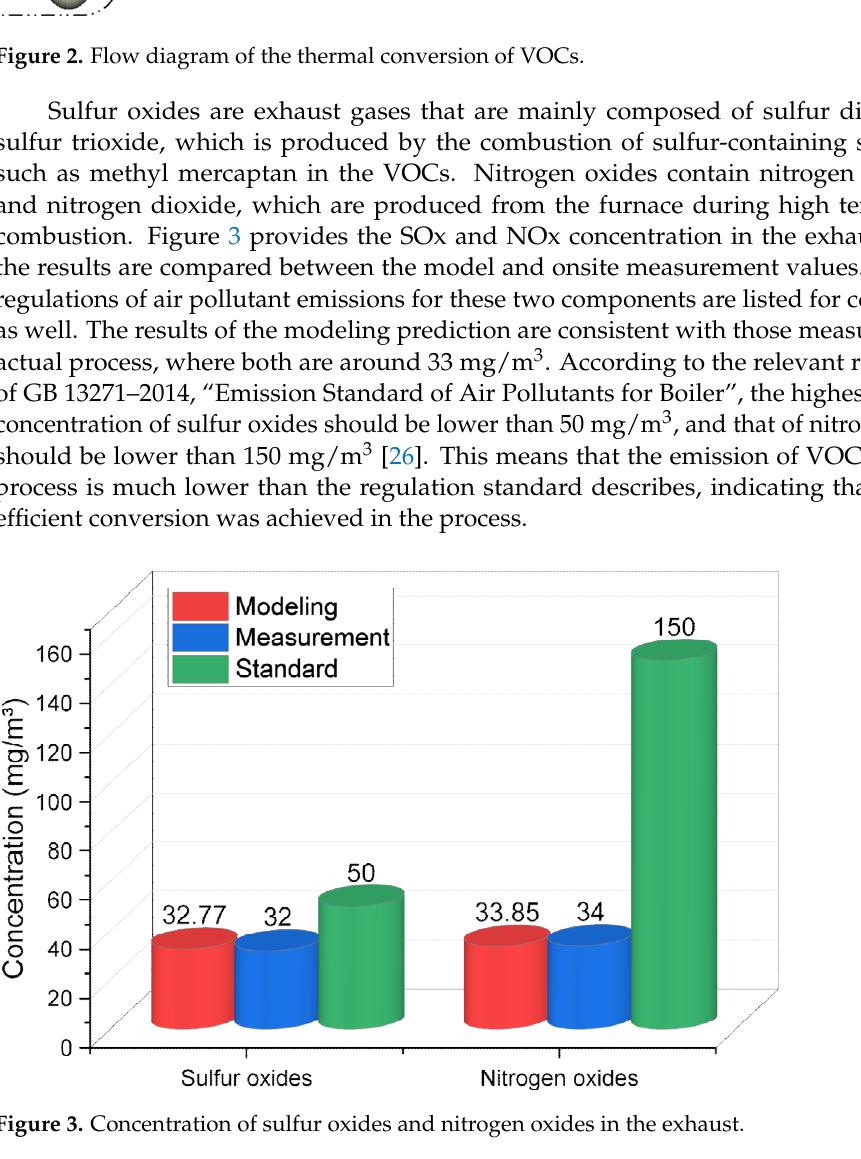
Figure 2. Flow diagram of the thermal conversion of VOCs.